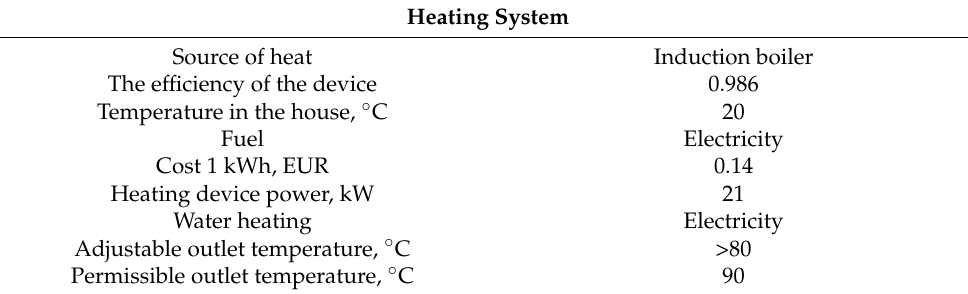
Table 13. Heating system: induction